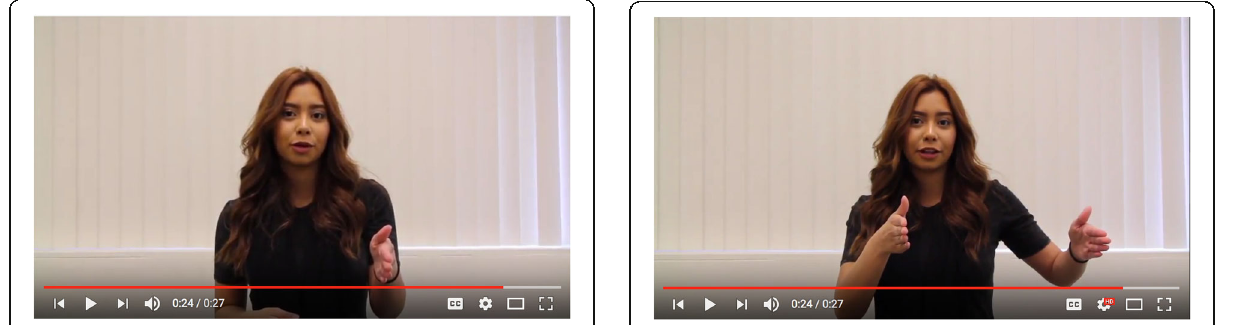
Fig. 1 Gesture used in the centrality condition. The left hand was used to show the mean of the group that studied with chocolate, the right hand, without chocolate. Only one hand was raised at a time. Gestures matched the words, representing the difference in the two means